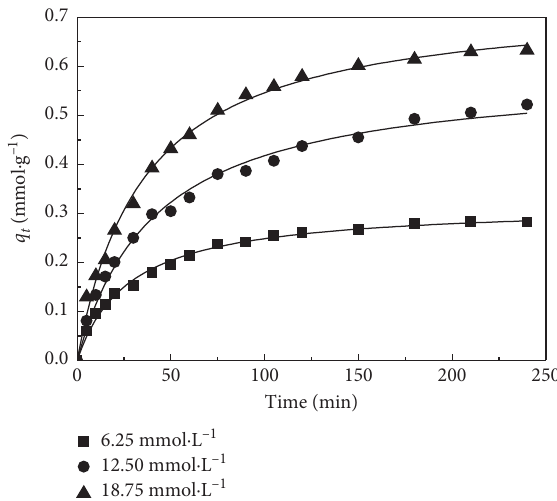
Figure 14: Nonlinear fitting of PFO model (adsorbent: 0.2 g 2 wt. %; v : 20mL; c 0 : 6.25, 12.50, and 18.75mmol · L − 1 DBT; adsorption oil time: 4 h; adsorption temperature: 313 K). Table 3: Nonlinear fitting parameters of three adsorption kinetic models (PFO, PSO, and MPnO) at different adsorption c 0 (6.25, 12.50, and 18.75mmol · L − 1